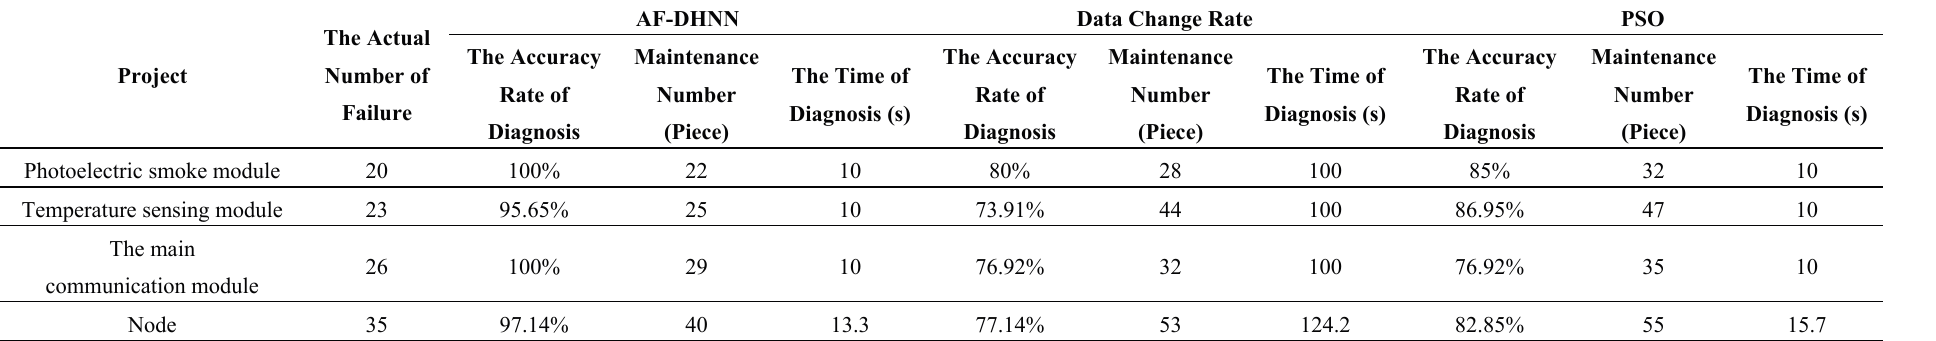
Table 4. Sensor faults diagnosis